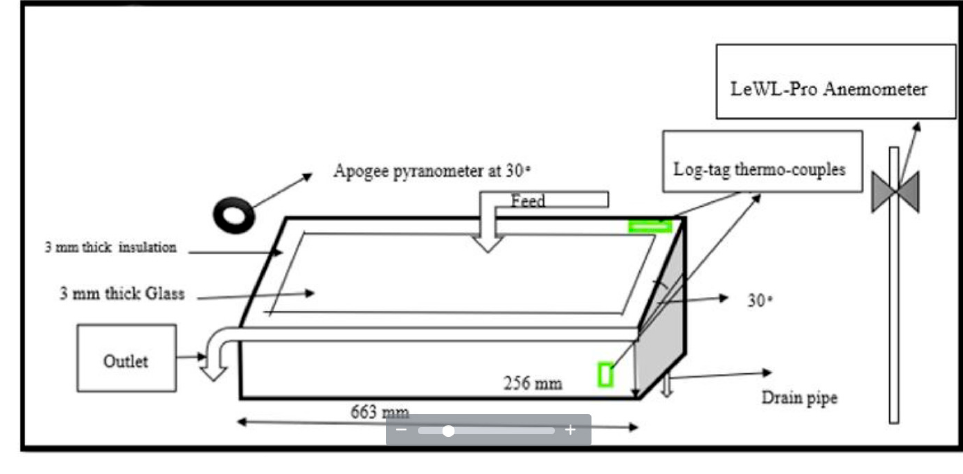
Figure 1. Experimental setup of solar still.